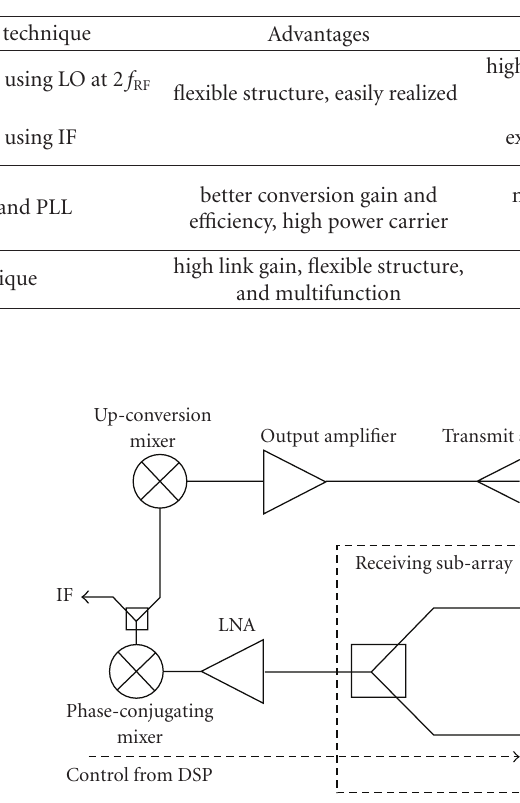
Table 2: Comparison of the major phase conjugation techniques.